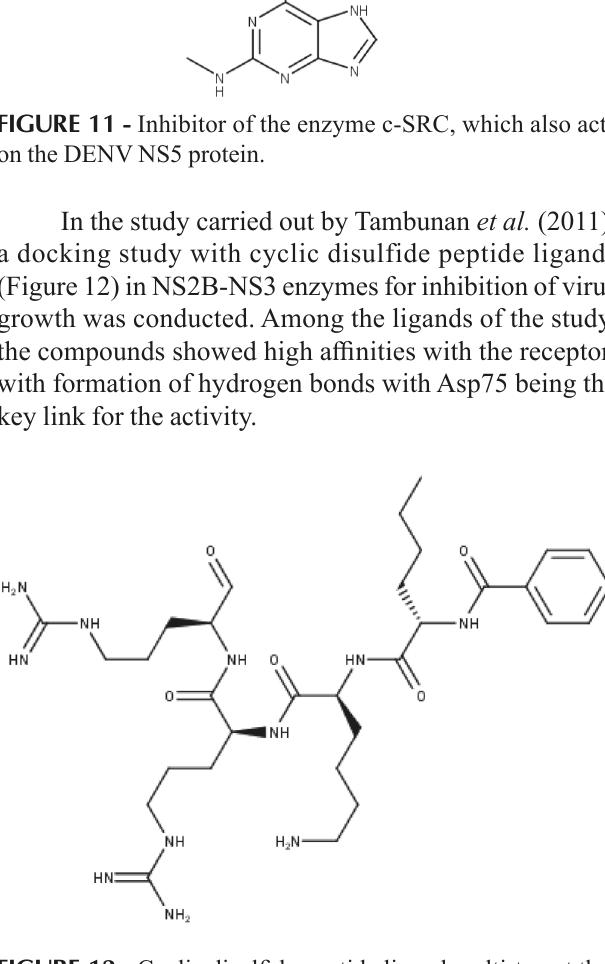
FIGURE 12 - Cyclic disulfide peptide ligand multi-target that acts on the NS2B-NS3